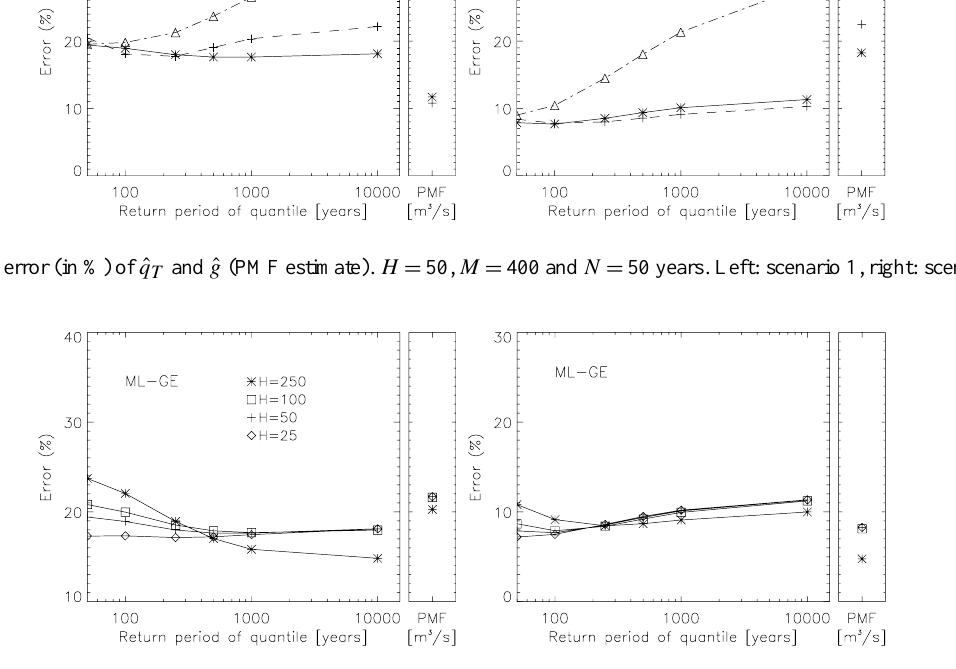
Fig. 5. Estimation error (in %) of ˆ q T and ˆ g (PMF estimate) for different H . M = 400 and N = 50 years. Left: scenario 1, right: scenario